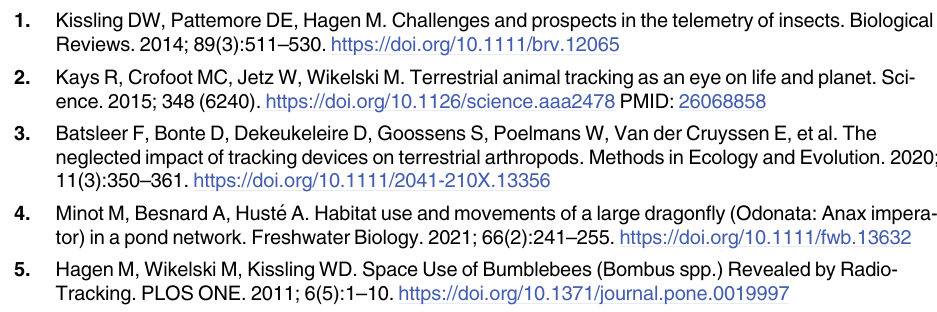
S2 Table. Effect of temperature on movement properties for crickets in separate tag weight categories and for control crickets. P-values of Mann-Whitney tests for the effect of tempera- ture on movement properties of crickets separately for each weight category (light, medium, heavy) and for control crickets. S3 Table. Effects of the indicated variables on the distance travelled movementSum by crickets over 3 days. S4 Table. Change in movement properties during 3 consecutive days. Medians and Wil- coxon test of differences in distributions of slopes of linear models that describe change in movement properties as affected by tag